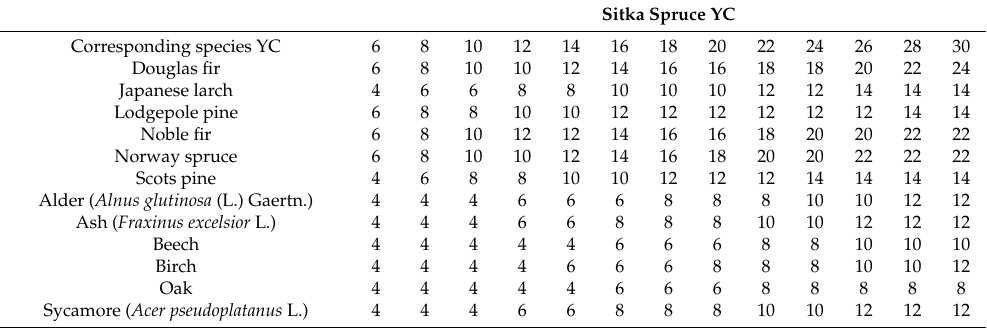
Table 4. Lookup table to determine the Yield Class (YC) (m 3 ha − 1 year − 1 ) of species based on the Sitka spruce YC [41].